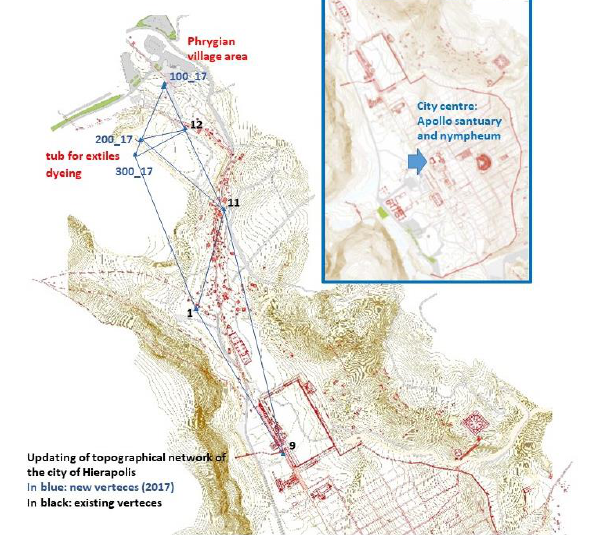
Figure 2. A part of the city map with the 2017 extension of the topographical network related to the location of the test sites.